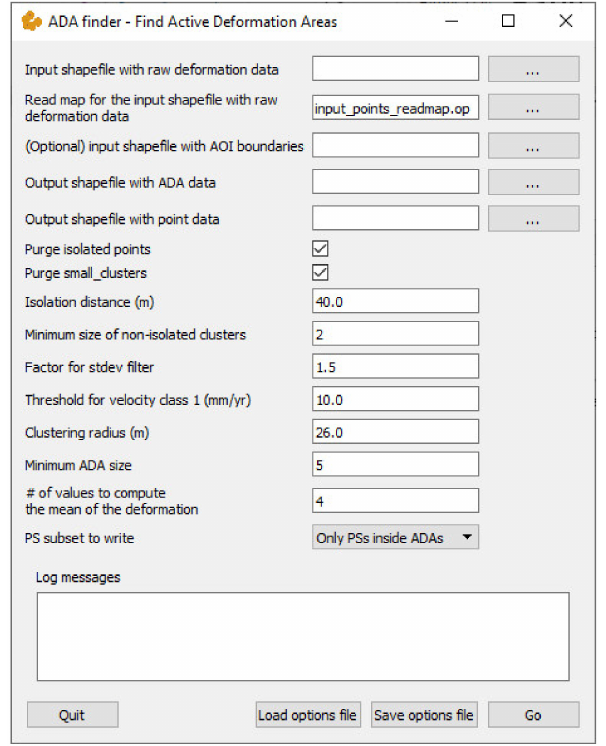
Figure 1. The graphical user interface (GUI) version of the ADAfinder